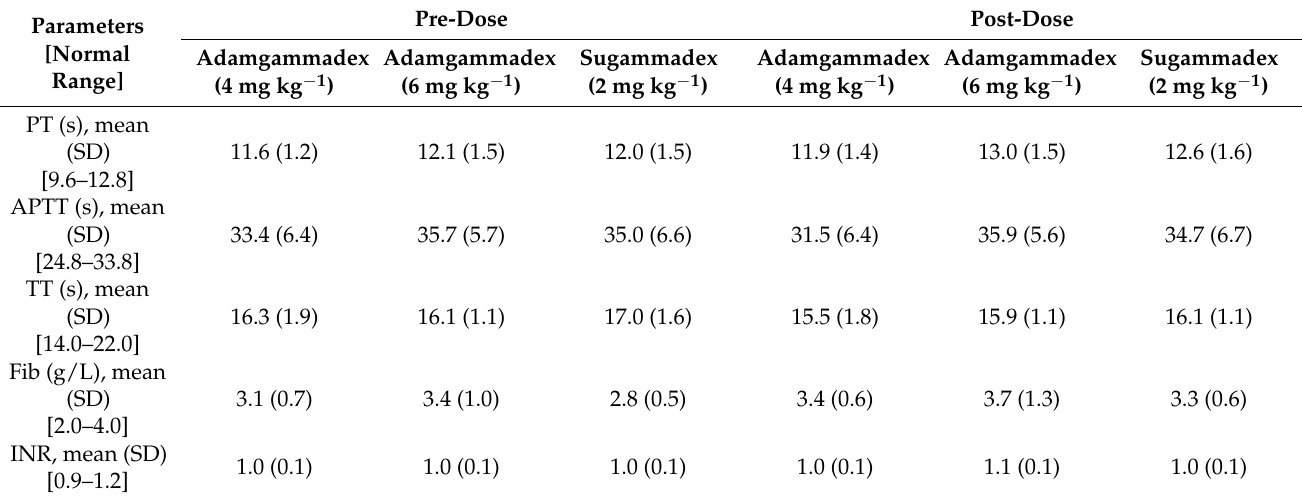
Table 3. The coagulation function.